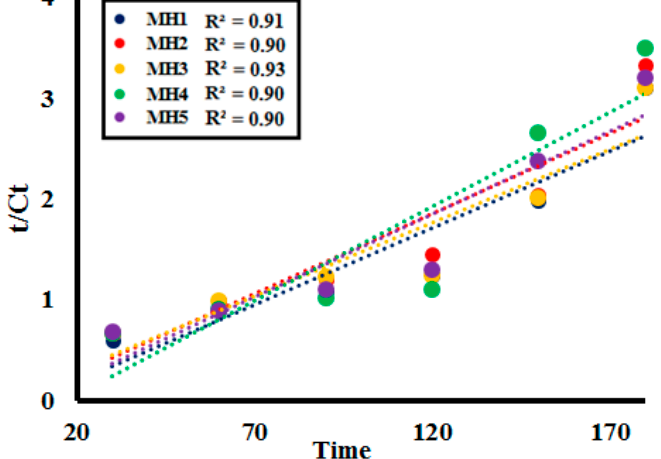
Figure 12. Pseudo second order kinetics of alizarin red ( AR) dye degradation at different time intervals by nanomaterials (MH1–MH5).